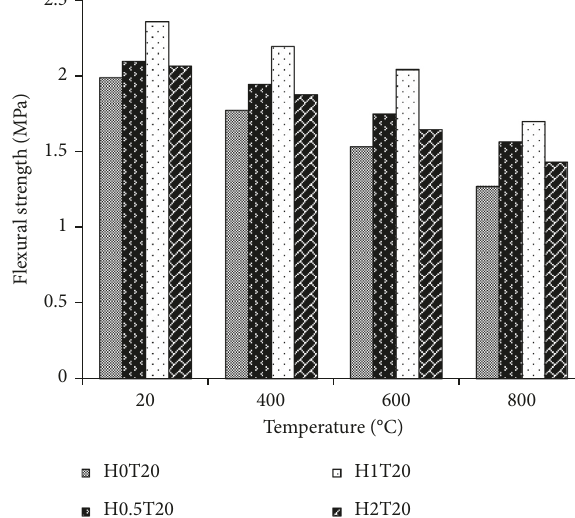
Figure 4: Flexural strength results for carbon fiber-reinforced lightweight concrete without silica fume.